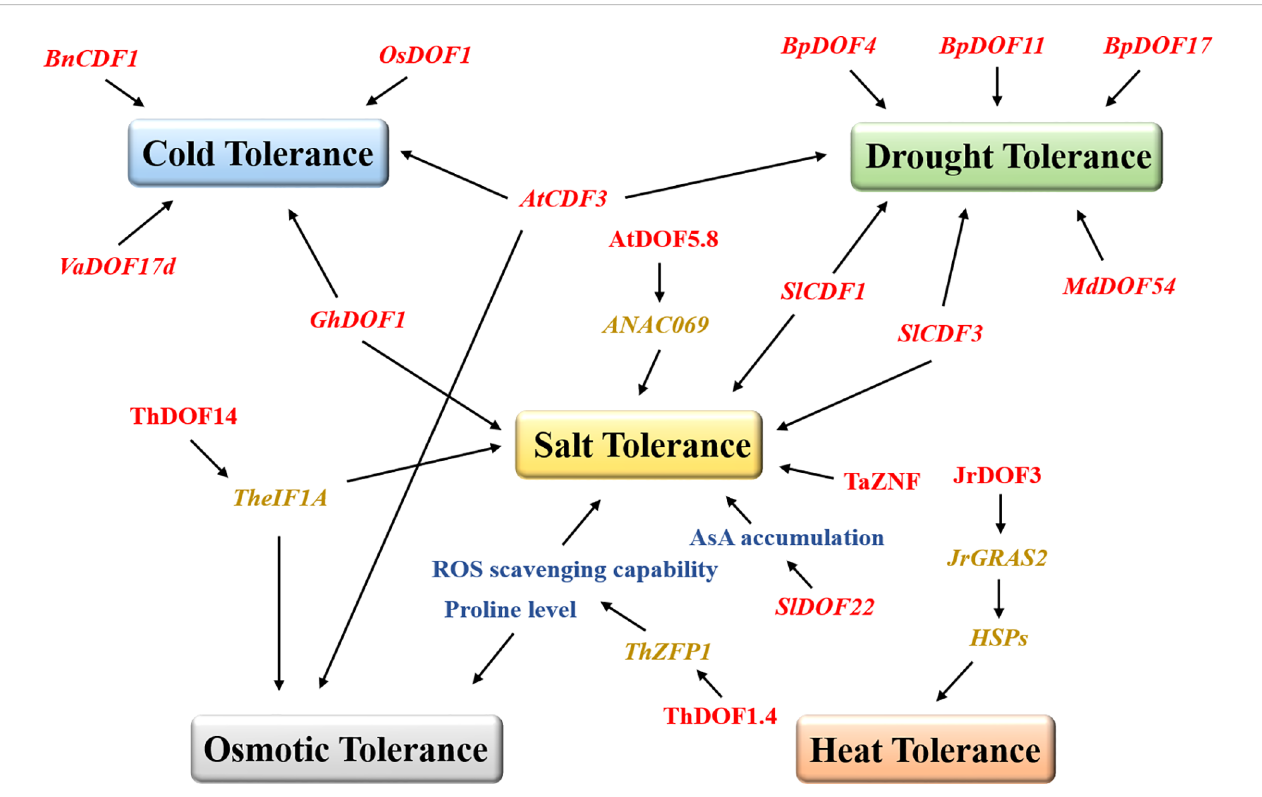
FIGURE 2 DOFs promote plant tolerance under different abiotic stresses. The DOF family members are represented in red, and the box marks resistance to different stresses. The blue, green, yellow, grey, and orange boxes represent cold tolerance, drought tolerance, salt tolerance, osmotic tolerance, and heat tolerance, respectively. The black arrows indicate facilitated relationships. AsA, ascorbic